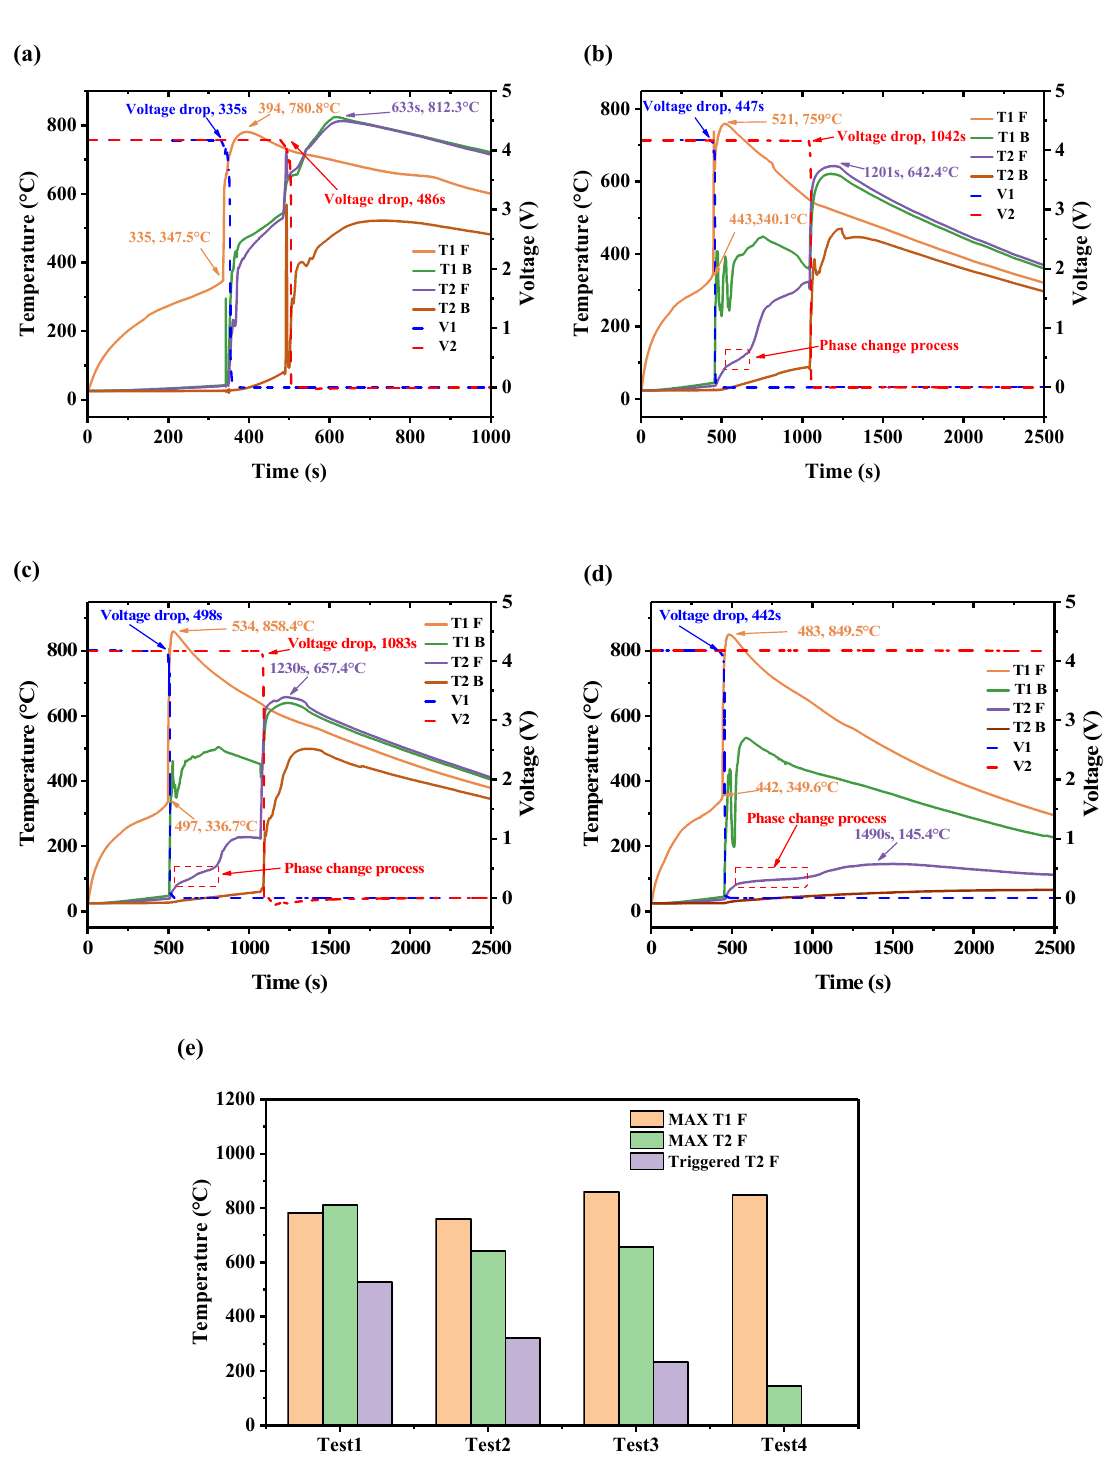
Figure 5. The variation in the temperature and voltage of the TR process: ( a ) test 1; ( b ) test 2; ( c ) test 3; ( d ); test 4; and ( e ) characteristic temperature of each